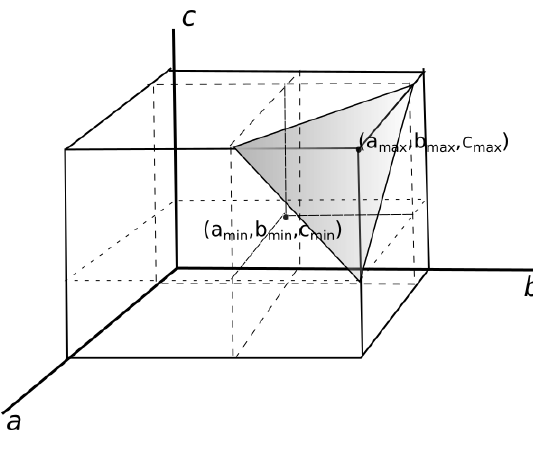
Figure 1 . Solution to the (cid:13) ij